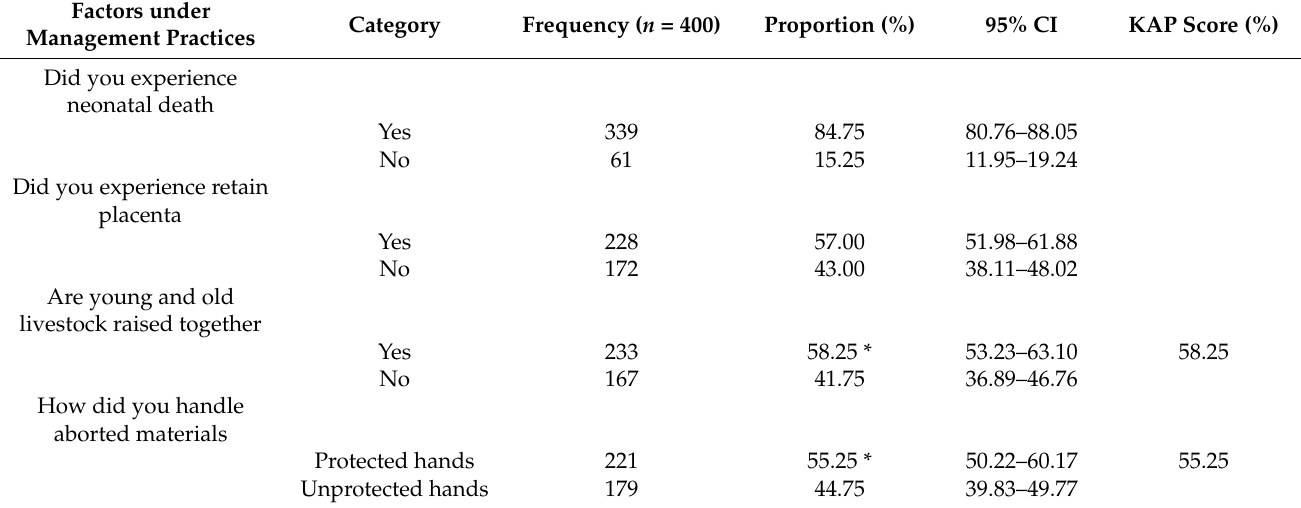
Table 3. Participants’ practice and management of livestock in terms of Rift Valley